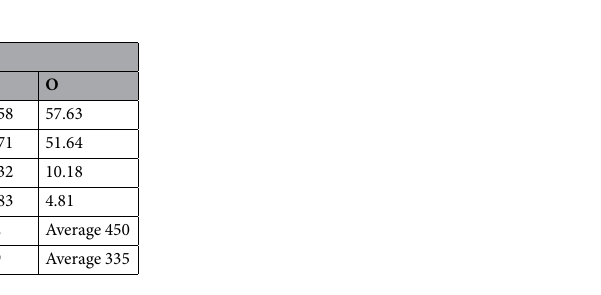
Table 1. Content and hardness of the regions indicated in Fig. 3.